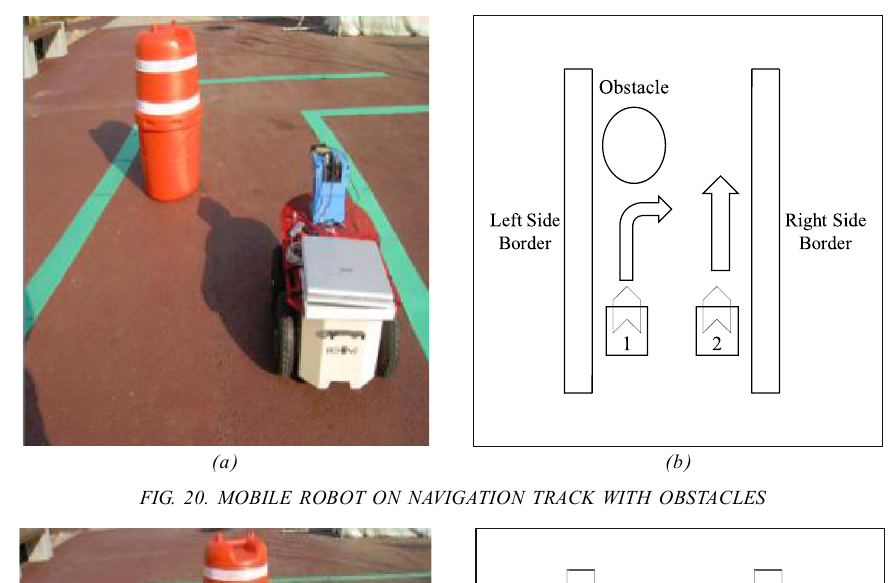
FIG. 20. MOBILE ROBOT ON NAVIGATION TRACK WITH OBSTACLES